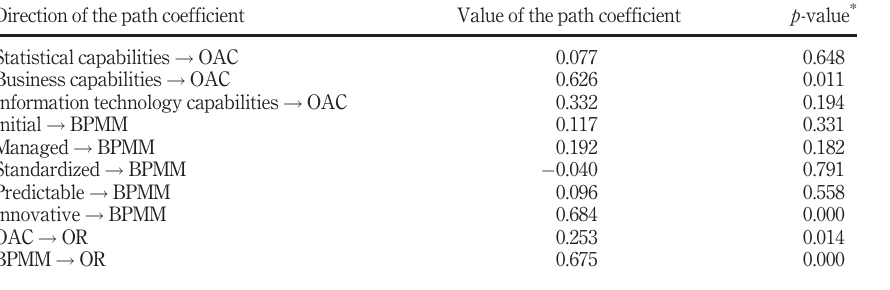
Table I. Total effects of